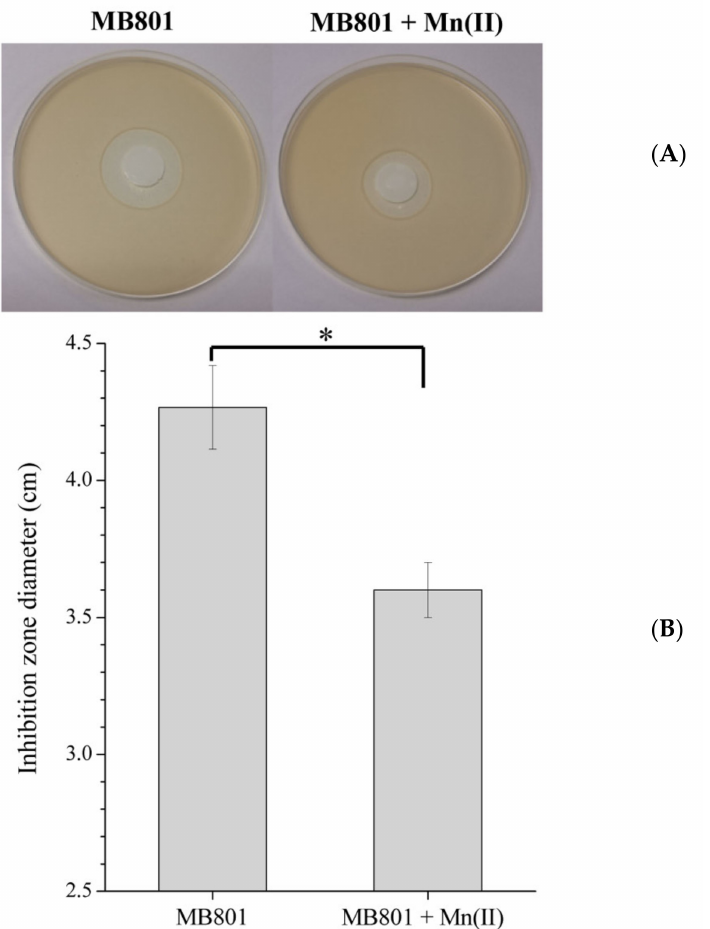
Figure 7. H 2 O 2 inhibition zone on the growth of MB801. In ( A ), sterile 6-mm-diameter filter papers were immersed in 10 µ L of 1 mol/L H 2 O 2 , and 5 mmol/M MnCl 2 was used as appropriate. In ( B ), the plotted inhibition zone diameters are shown with/without MnCl 2 supplementation. Means followed by * in a column were significantly different ( n = at least 3; p <